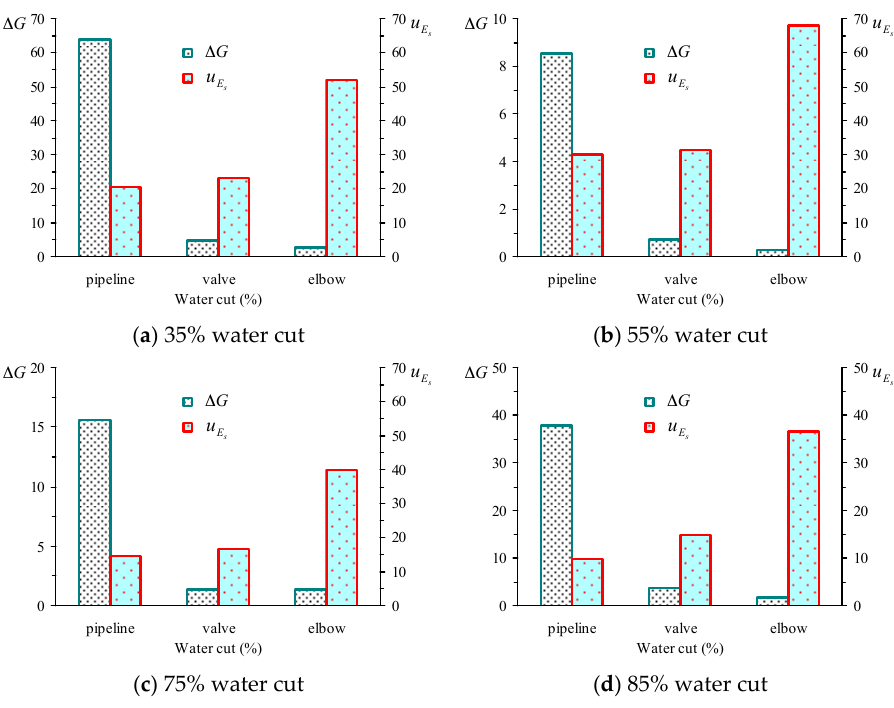
Figure 11. Effect of flow region on shearing energy and interfacial Gibbs free energy change.